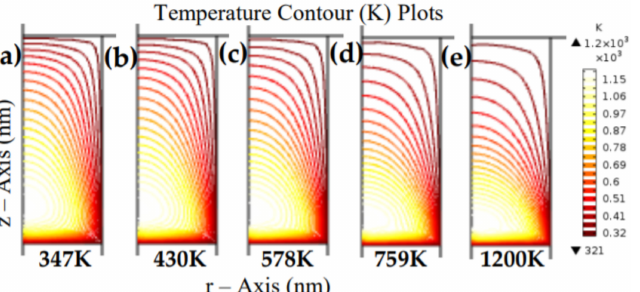
Figure 10. Reset thermal energy due to Joule heating displaying: ( a ) initial reset ambient temperature after the RESET process, ( b – e ) the RESET temperature rise due to the application of reverse polarity (the charged CF opposes the vicinity’s polarization). The device’s temperature rise is due to charged CF acquiring charges opposite to the initial polarity; as such, the radially developed CF is dissociated and thus creates